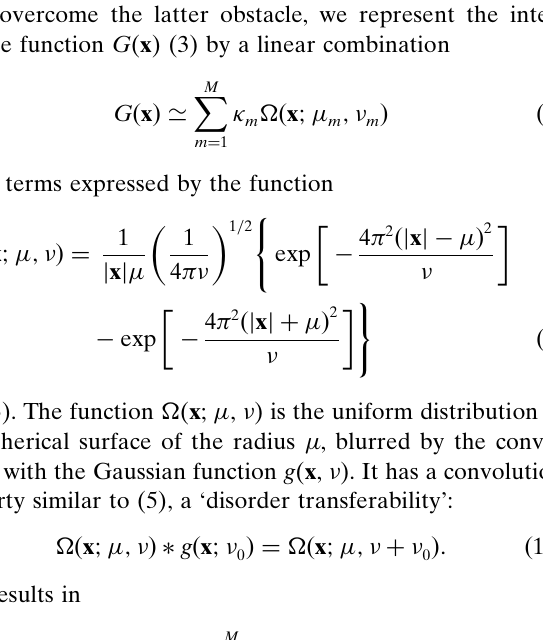
Table 1 Coefficients of the shell decomposition (8) of the function G ( x ) obtained for | x | (cid:5) 10, M = 21 [see Fig. 3( b )]. The central peak of G ( x ) is represented by the sum of the Gaussian function ð Þ ¼ (cid:7) ð Þ and the correcting function (cid:7) (cid:7) (cid:2) x ; 0 ;(cid:6) g x ; (cid:6) 1 1 1 1 Fourier ripple is represented by one (cid:7) m (cid:2) x ; (cid:5) m ;(cid:6) m ð